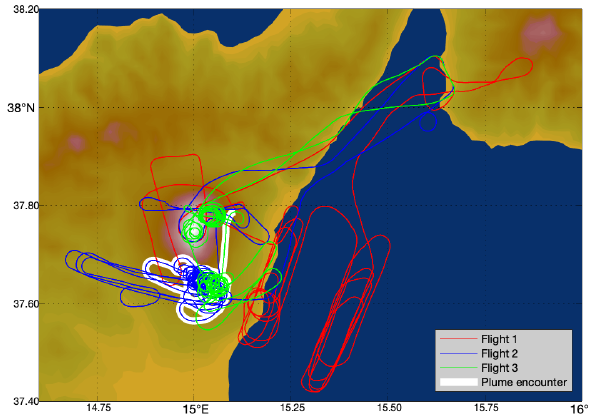
Figure 2. Flight paths of the aircraft on the 3 measurement days: red – 30 July 2012, blue – 31 July 2012, green – 1 August 2012. Major plume encounter locations as identified by our algorithm are highlighted in